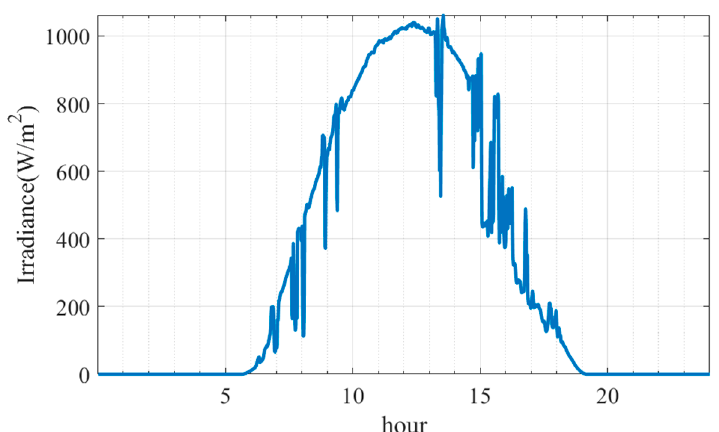
Figure 6. Wind speeds through a typical day.